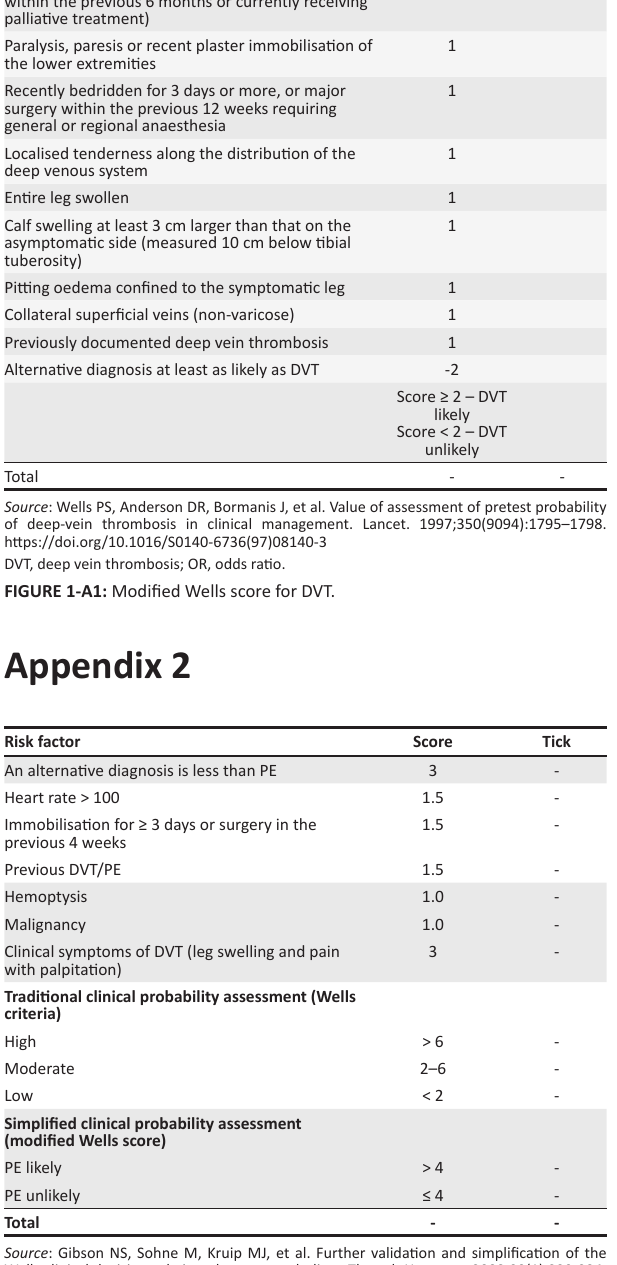
FIGURE 1-A2: Modified Wells score for pulmonary